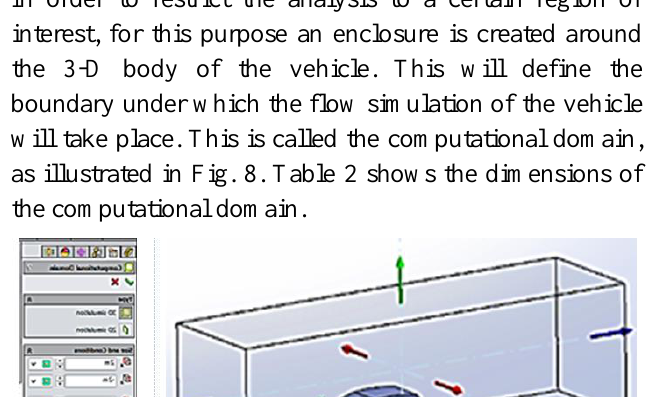
Fig. 6. Blueprints of Suzuki Wagon R 2012 (a) Front view (b) Side view (c) Back view